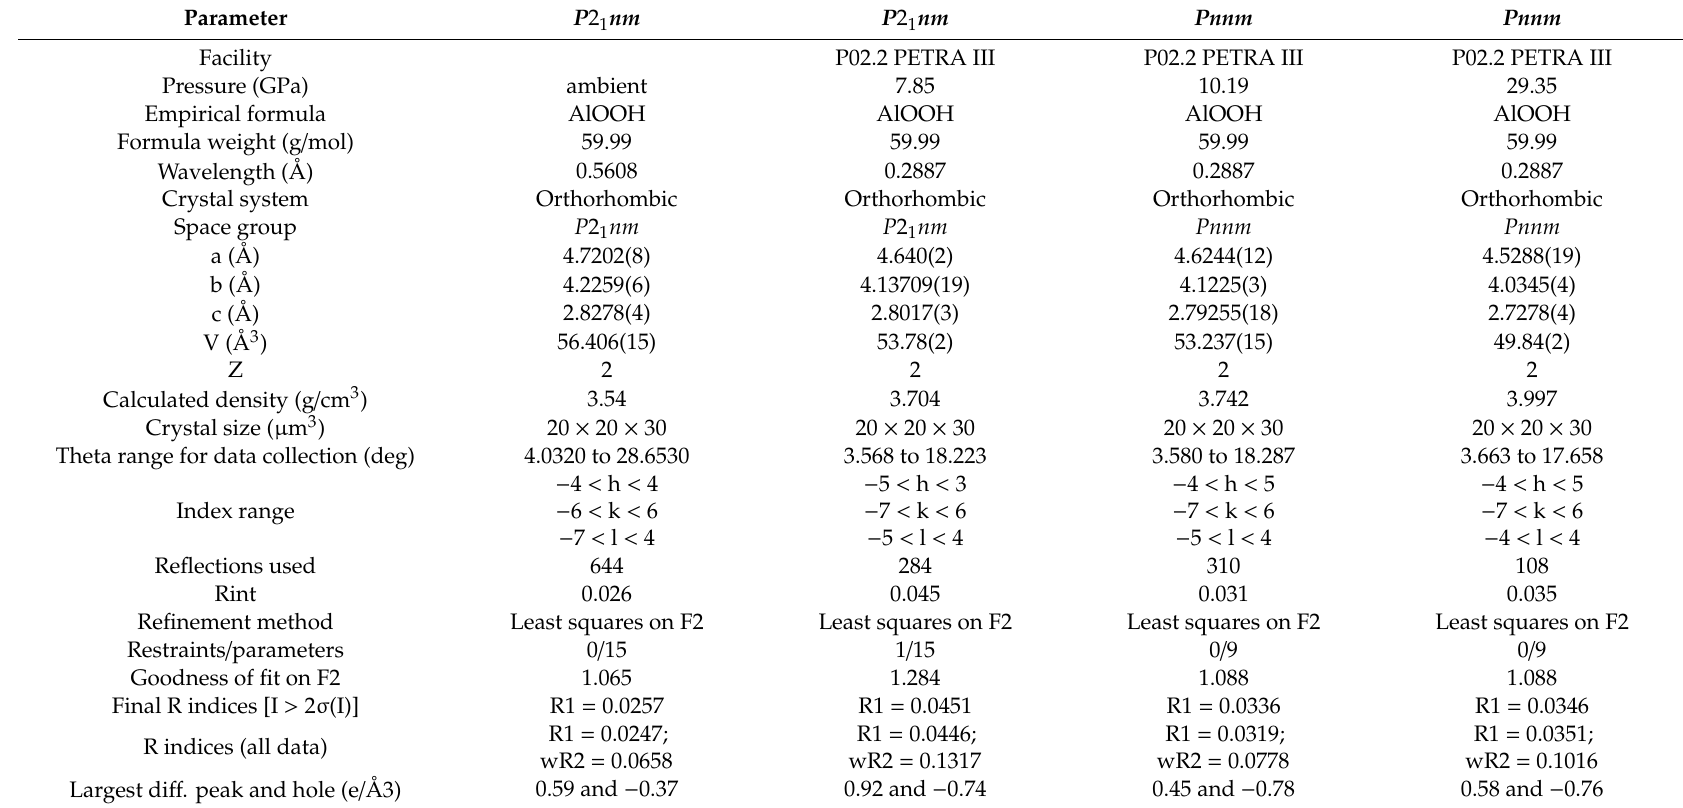
Table 1. Crystallographic data for P 2 1 nm (7.85 GPa) and Pnnm (10.19 GPa) phases of δ -AlOOH at room